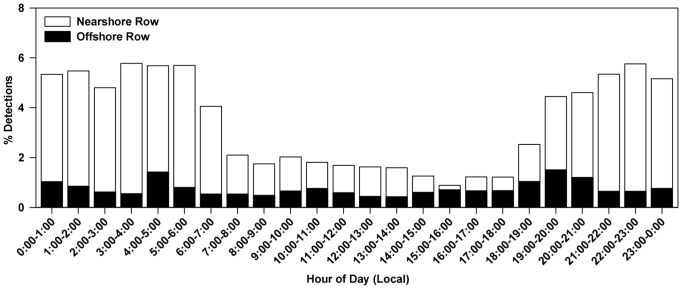
Distribution of lemon shark detections by receiver row and by hour of day. Nearshore receivers were located 250 m from the beach while offshore receivers were 1250 m from the beach.